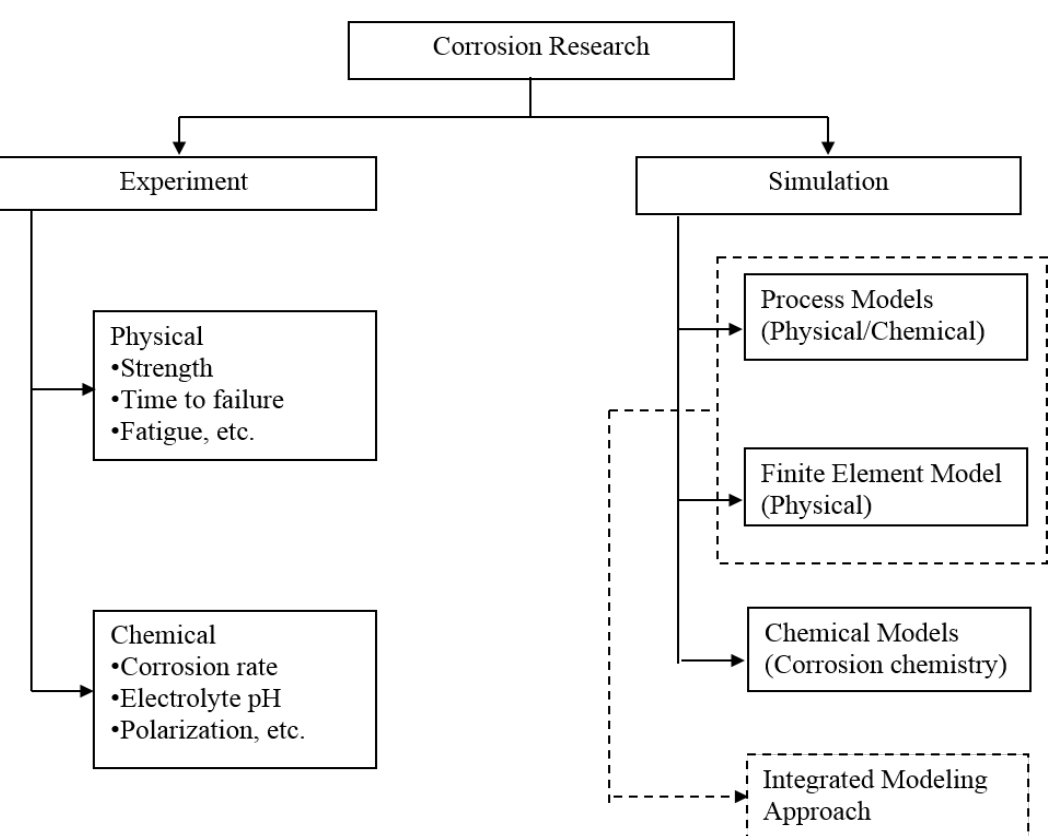
Figure 1. State-of-art research in corrosion mechanics of magnesium alloys.